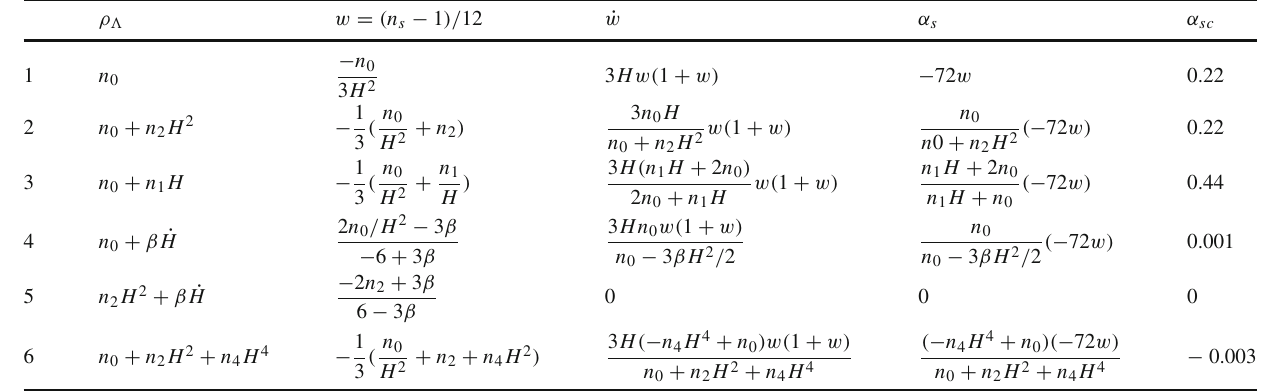
Table 1 Summary of all cases in RVM-bounce scenario . Note that in all cases, w has a small negative value (see Eq. (61)). Also the running α α = H = − 8 . 8 × 10 − 8 (in con- sc is the value of s at crossing, H cr